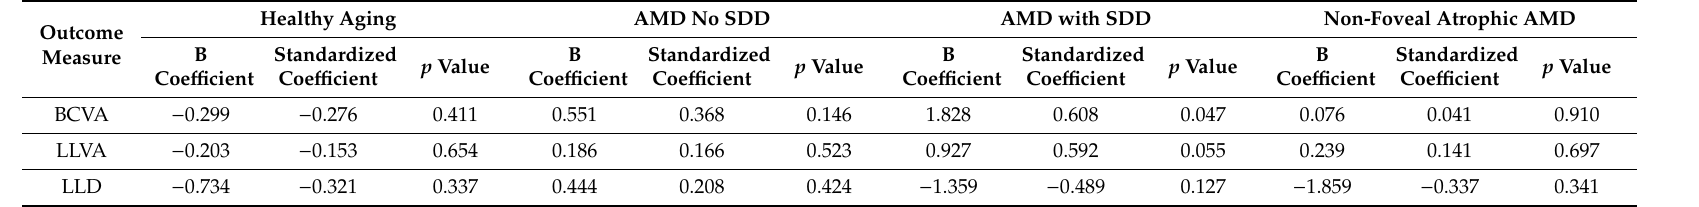
Table 3. Univariate linear regression of functional tests against LLQ Composite Score in all AMD severity